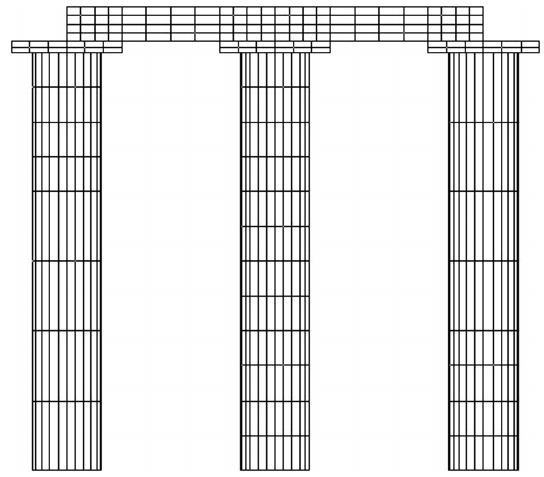
Figure 7: Acceleration of the capital for non-isolated and linearly isolated columns.